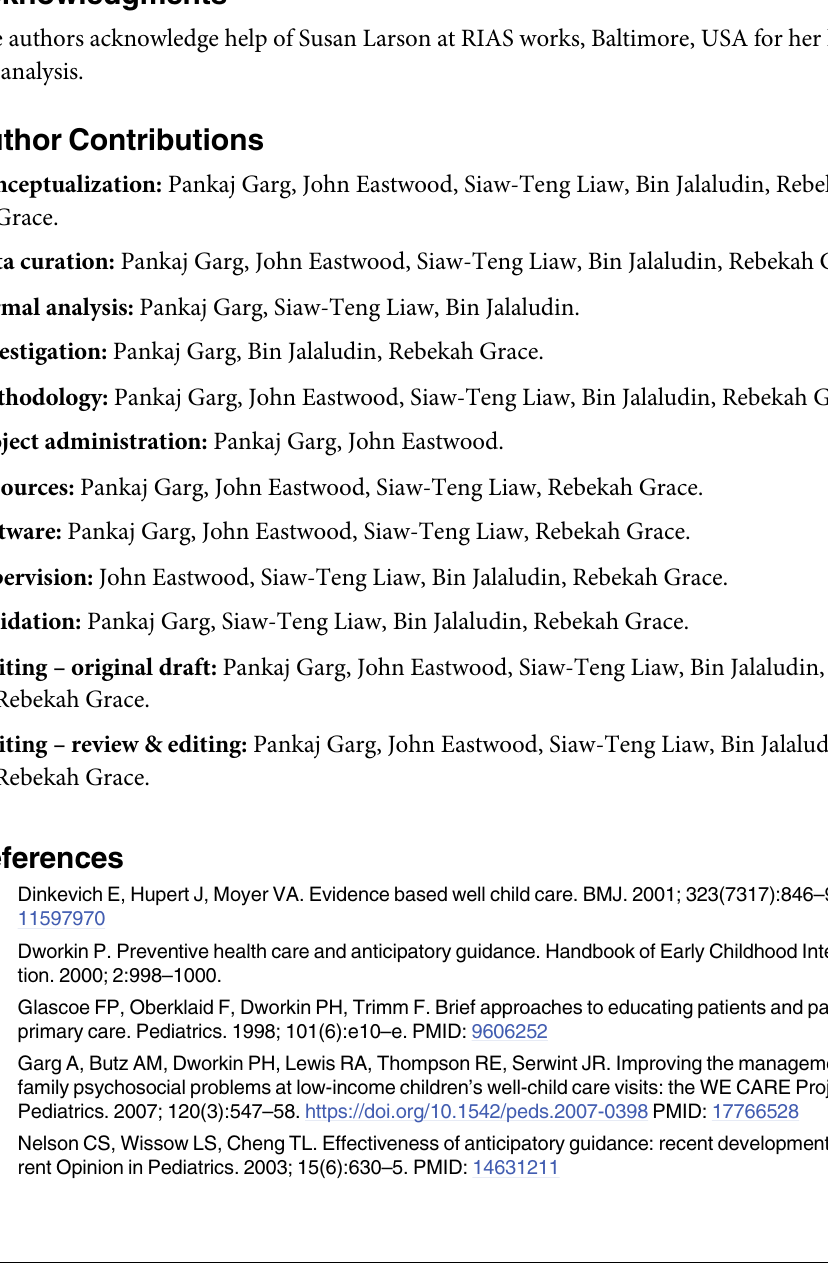
WCC coding Fig F. Histogram and normal P-P Plot of standardised residual dependent vari-